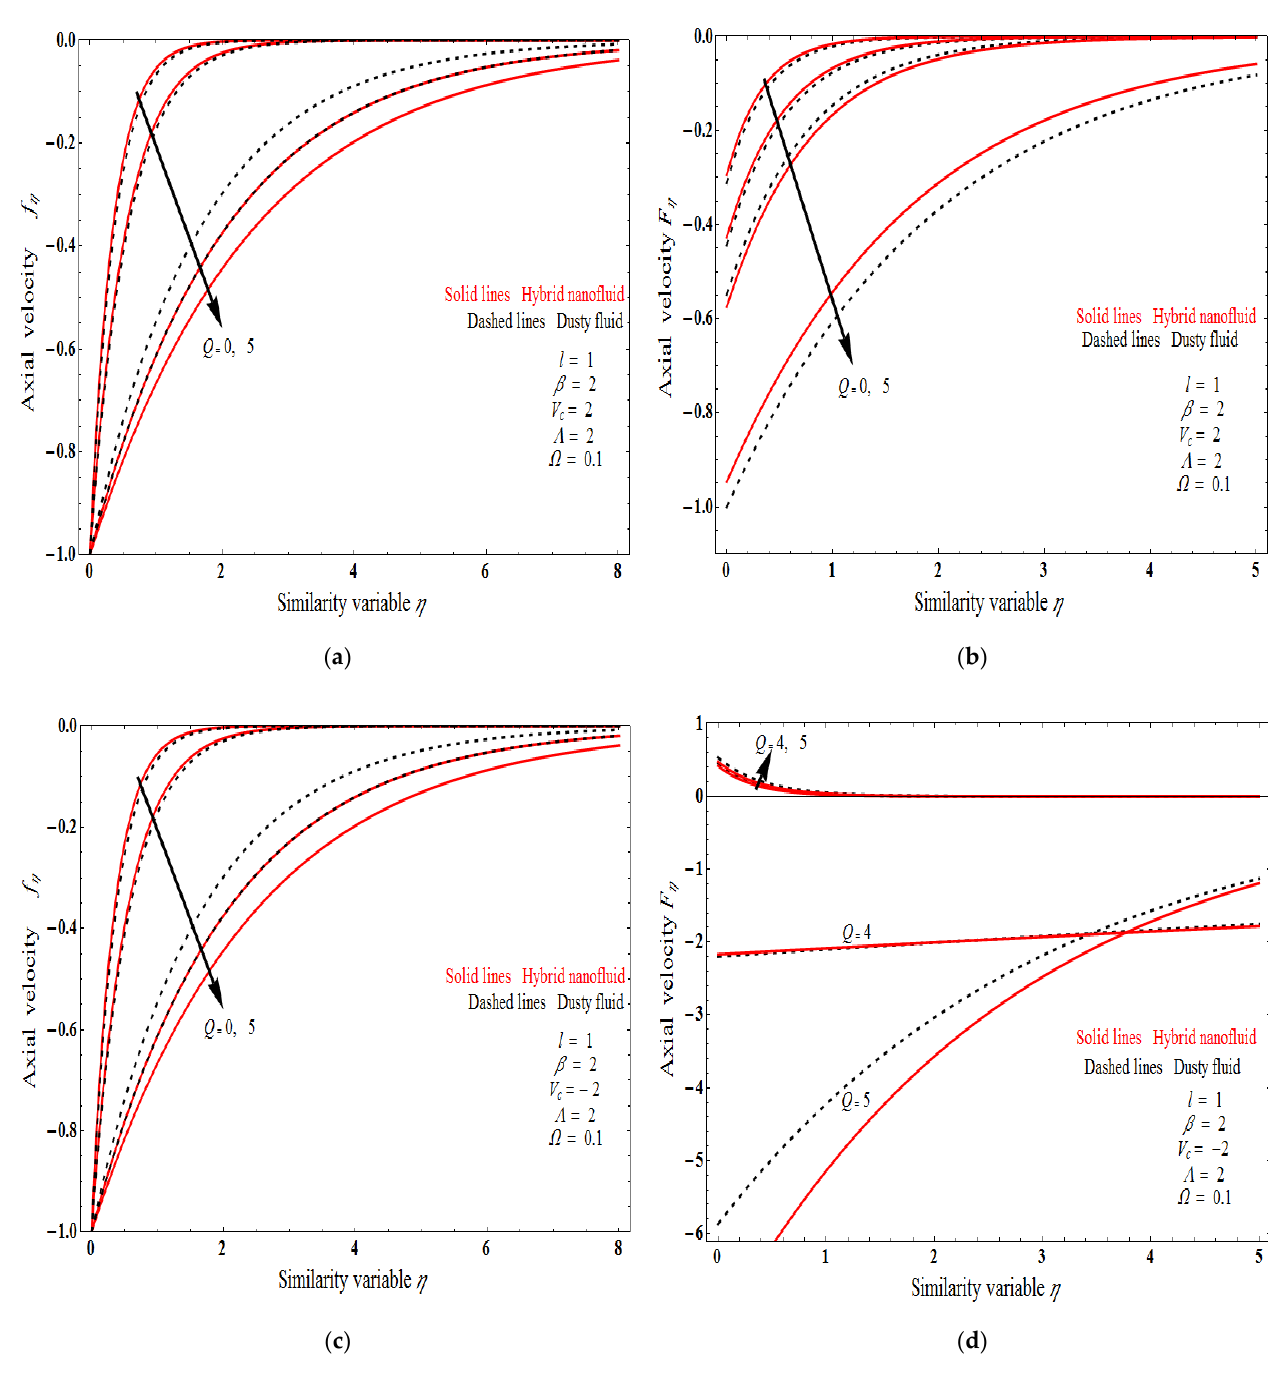
Figure 6. Influence of fluid velocity f η and particle velocity F η for the Shrinking surface: ( a ) f η for suction case, ( b ) F η for suction case, ( c ) f η for injection case and ( d ) F η for injection